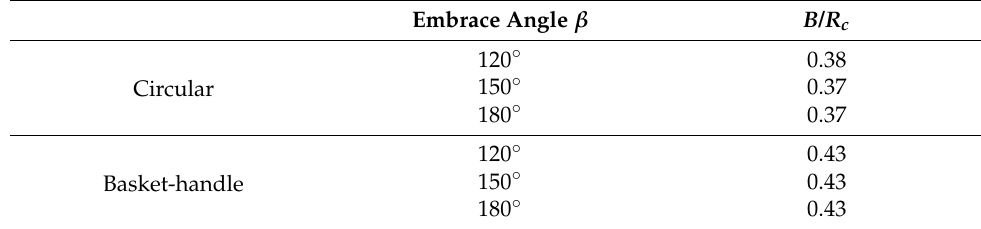
Table 5. Minimum statically stable B / R c .